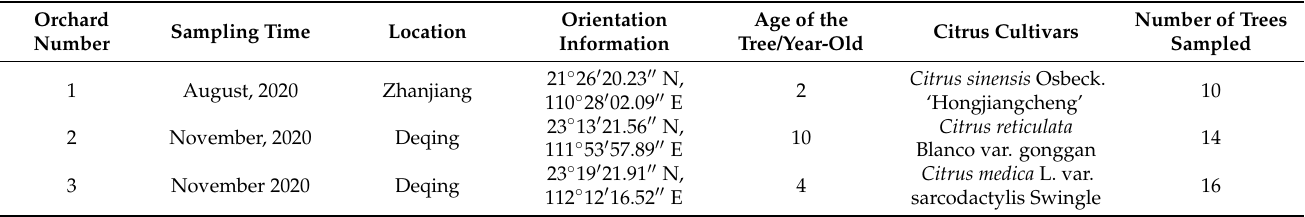
Table A1. Information on plants collected from three citrus orchards in Guangdong